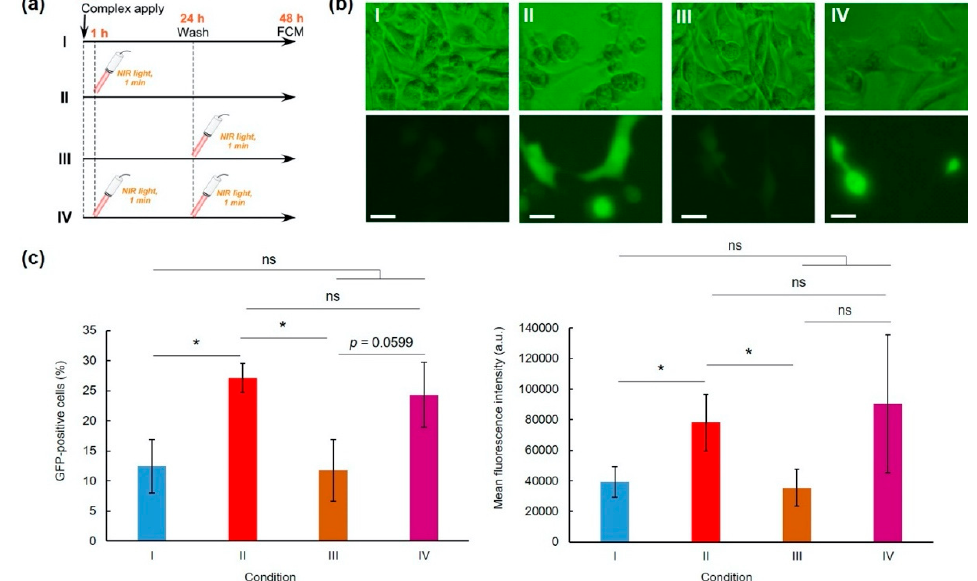
Figure 3. E ff ects of NIR laser irradiation condition on pDNA-hybrid vector complex transfection activity (L / P = 48). ( a ) Experimental conditions. HeLa cells were incubated with complexes for 24 h and were washed three times using PBS. After additional 24 h culture, GFP expression was evaluated using a flow cytometer: condition I, no laser irradiation; condition II, NIR laser irradiation at 1 h after sample apply; condition III, NIR laser irradiation at 24 h after sample apply; and condition IV, NIR laser irradiation applied at 1 and 24 h after sampling. Representative fluorescence images ( b ) and GFP-positive cells and GFP expression levels ( c ) of HeLa cells under various conditions ( n = 3–4). Scale bars represent 10 µ m. Statistical analyses were done using analysis of variance (ANOVA) with Tukey’s test. * p < 0.05 compared with other groups, ns; not